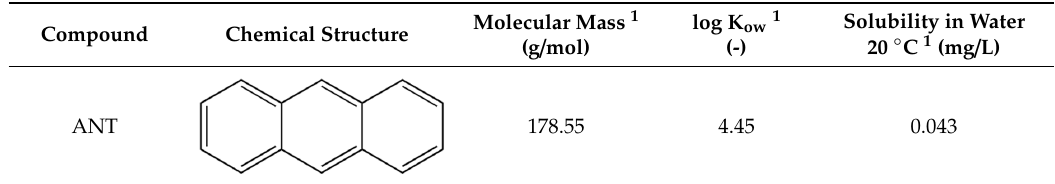
Table 2. Properties of anthracene.